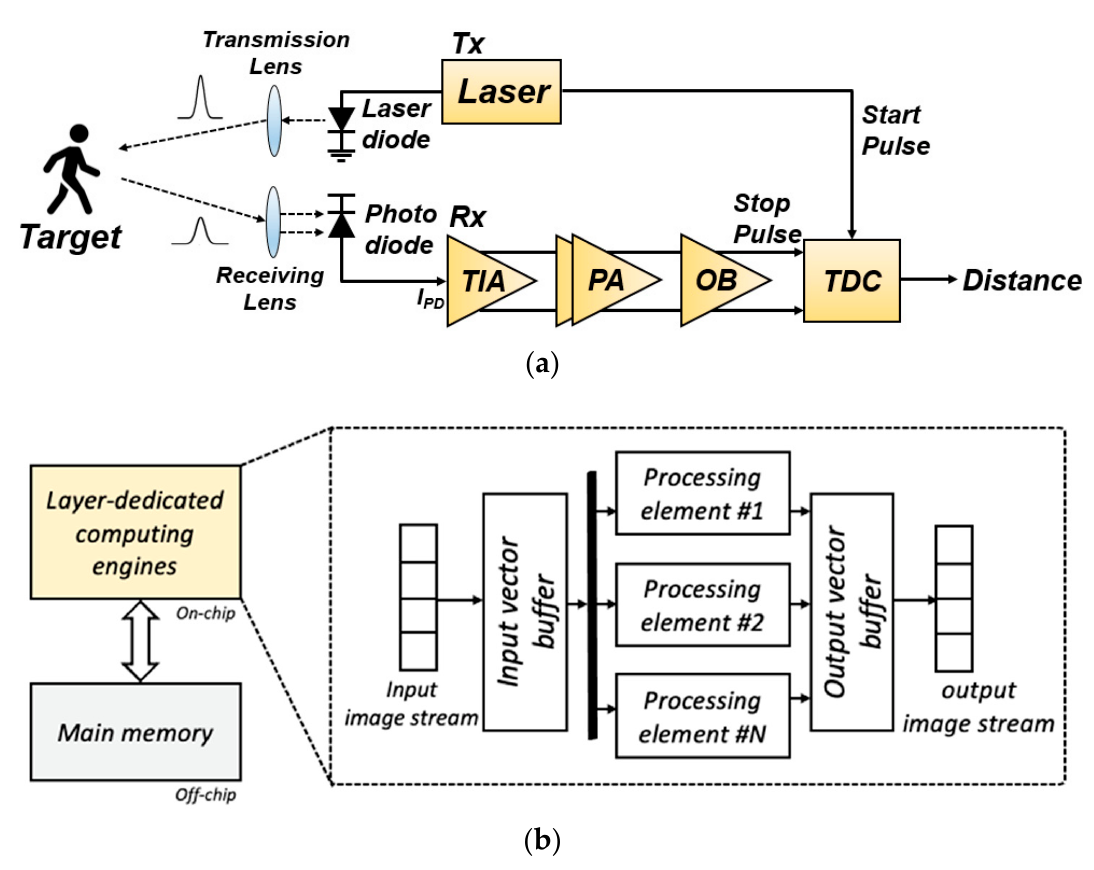
Figure 3. Block diagrams of the proposed optoelectronic Rx IC: ( a ) AFE circuit, ( b ) NPU.